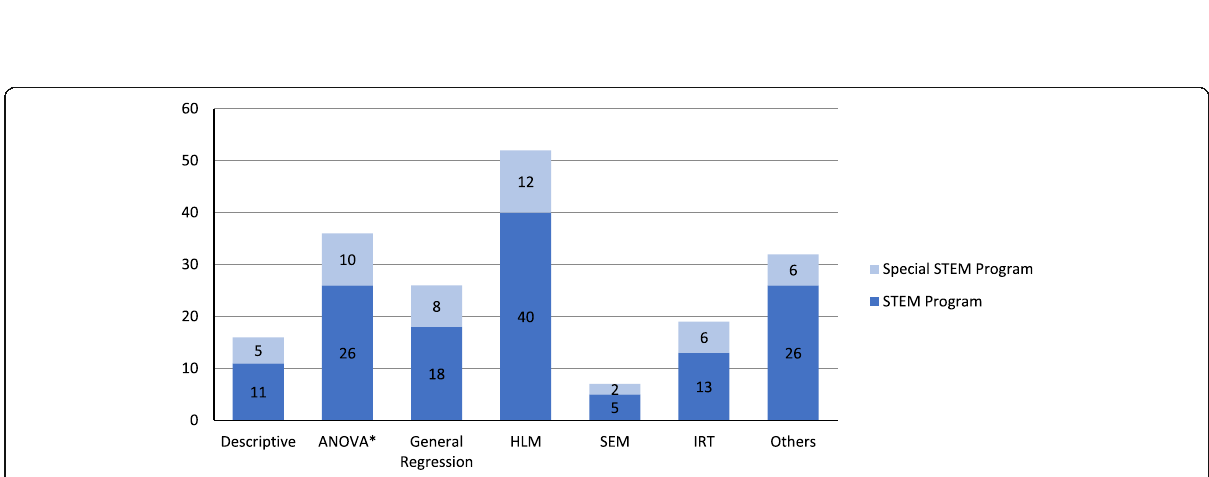
Fig. 22 The number of projects categorized by the type of data analysis methods